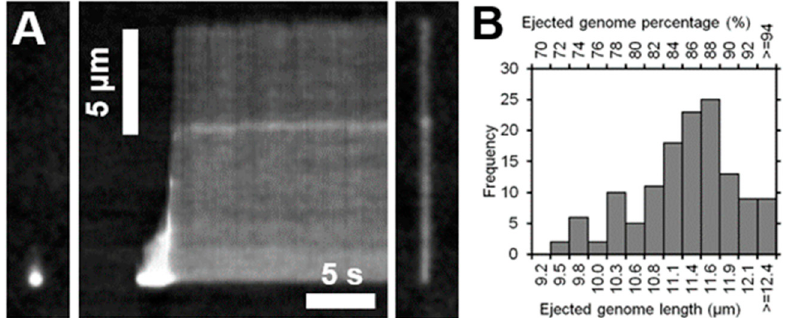
Figure 4. Bacteriophage DNA ejection in solution. ( A ) Images (left and right), and kymograph (middle) of a bacteriophage ejecting its DNA. ( B ) Distribution of ejected genome fractions. Ejection was never complete, and the majority of the viral genome (84 ± 5%; n =